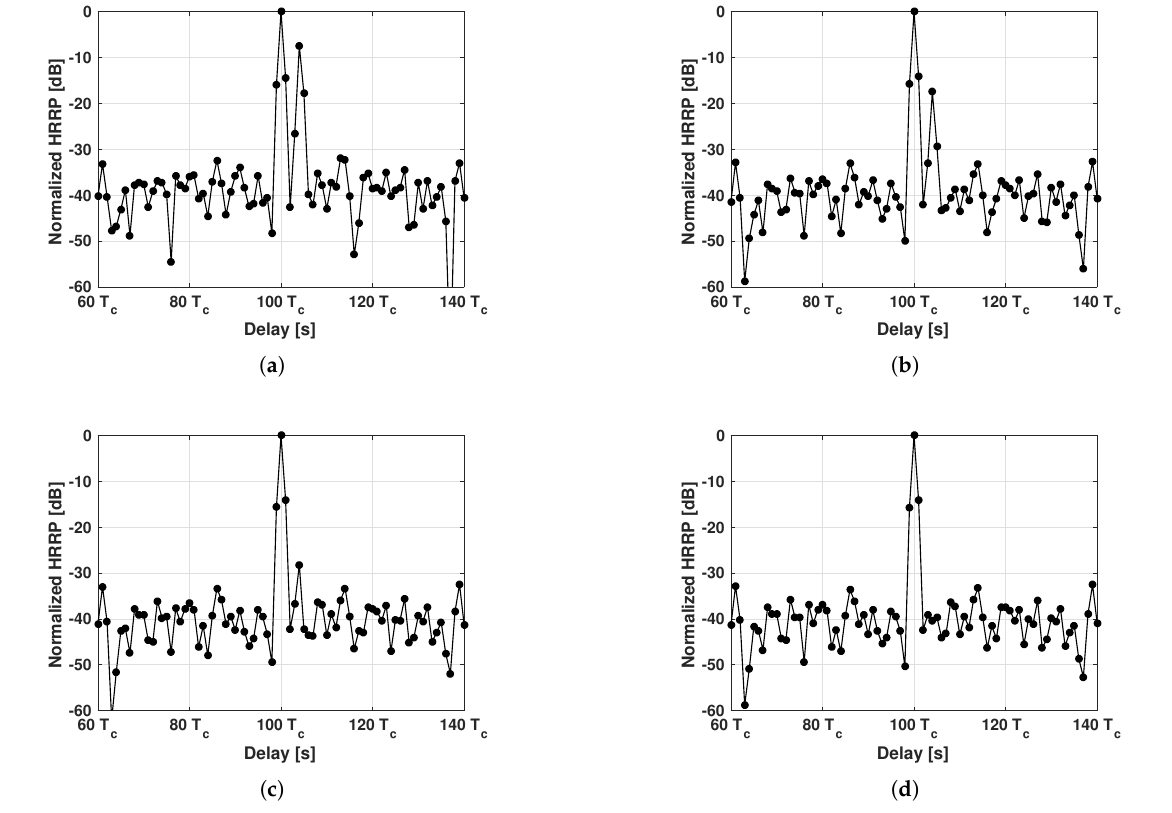
Figure 13. Resulting range profiles obtained for the test described in Section 5.2. They were normalized to the respective peaks, placed at bin #100. The various profiles were obtained considering for the secondary scatterer different attenuation with respect to the main one: 7 dB ( a ); 17 dB ( b ); 27 dB ( c ) and 37 dB ( d